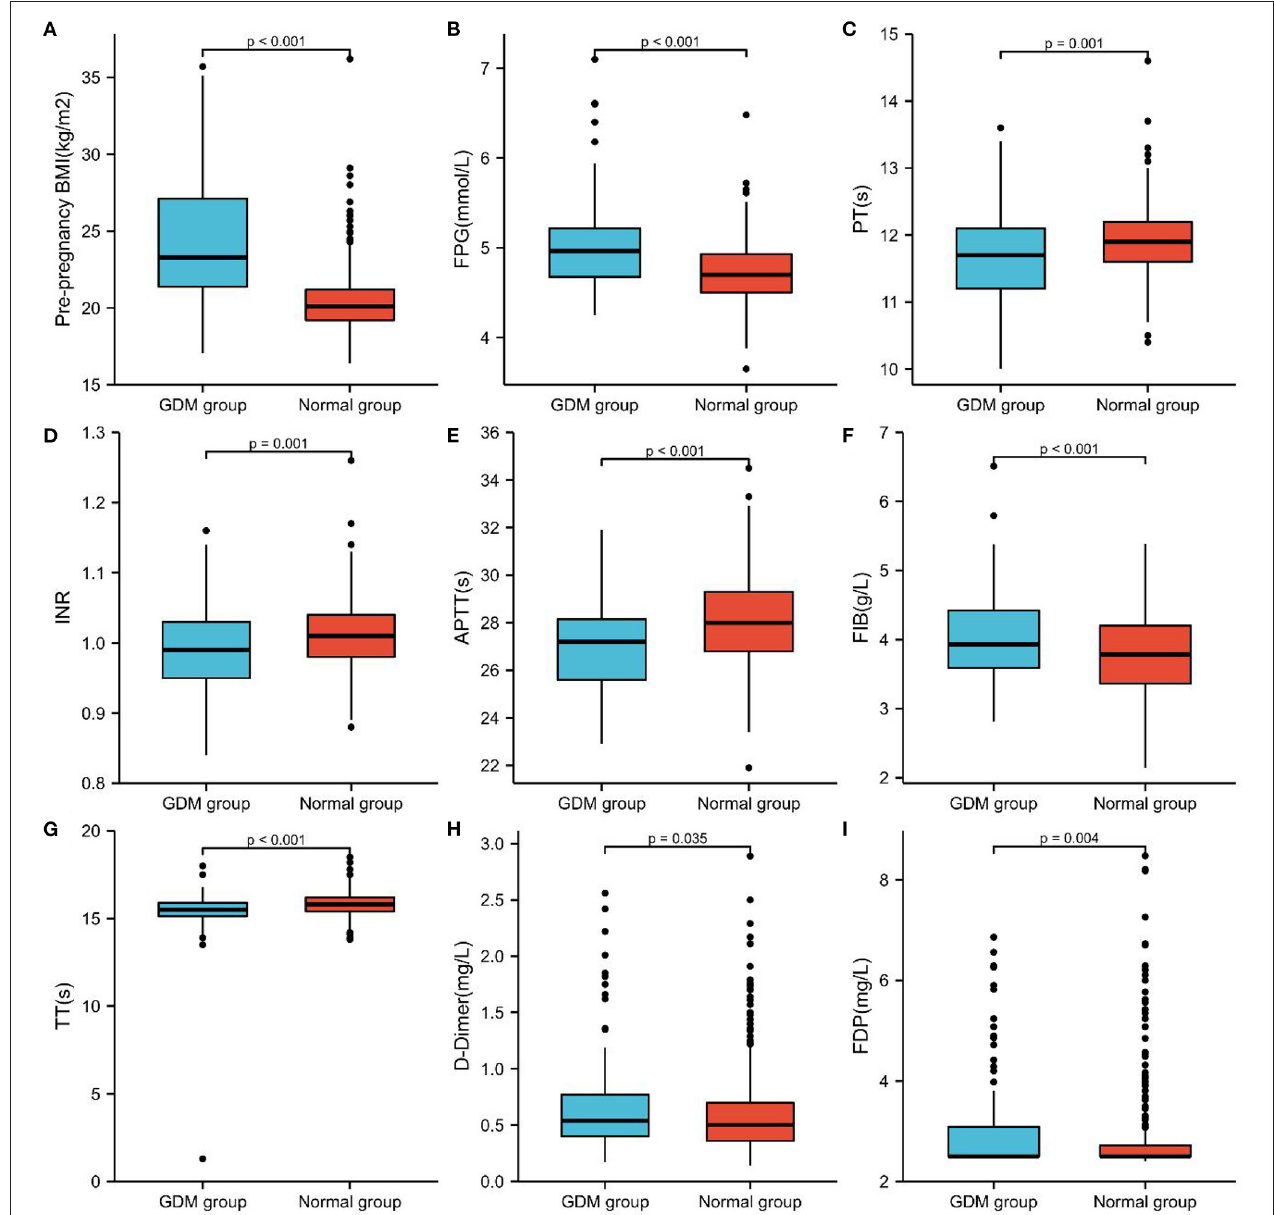
FIGURE 1 | Comparison of Pre-pregnancy BMI, FPG and coagulation function of the two groups in pregnant women with GDM and non-GDM. (A) Pre-pregnancy BMI, (B) FPG, (C) PT, (D) INR, (E) APTT, (F) FIB, (G) TT, (H) D-D dimer, and (I)